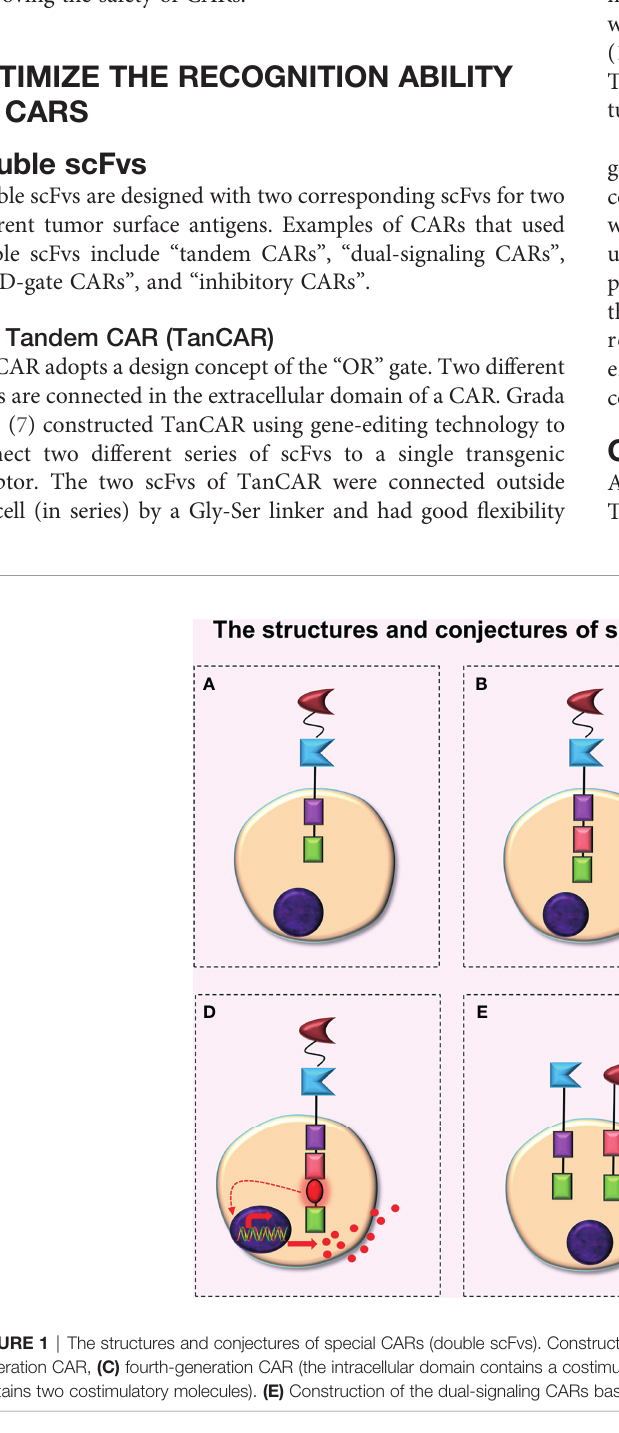
( Figure 1A ) . The TanCAR, which is activated when any one of the scFvs binds to a target antigen, can enable a CAR-T cell to synchronously recognize two types of tumor surface antigens.